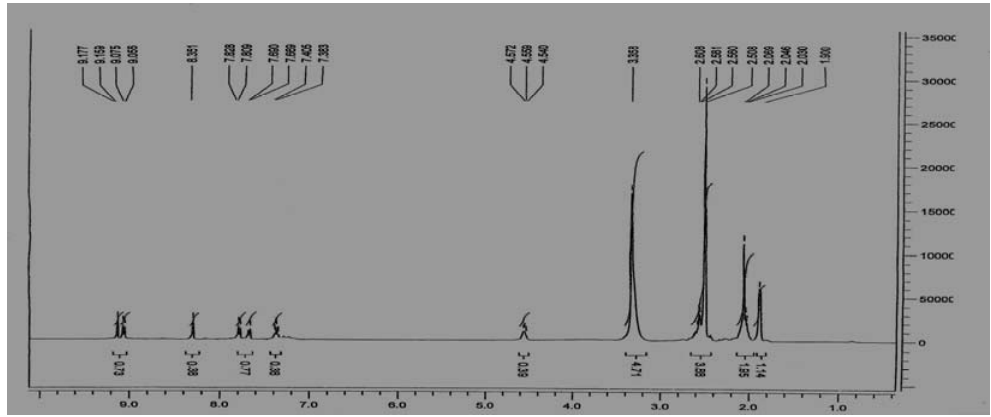
Figure 4. 1 H-NMR spectrum of the α -[ N -di-( β -chloroethyl)-amide] of N'- ( meta -acetylaminobenzoyl)- D,L -methionine ( 21